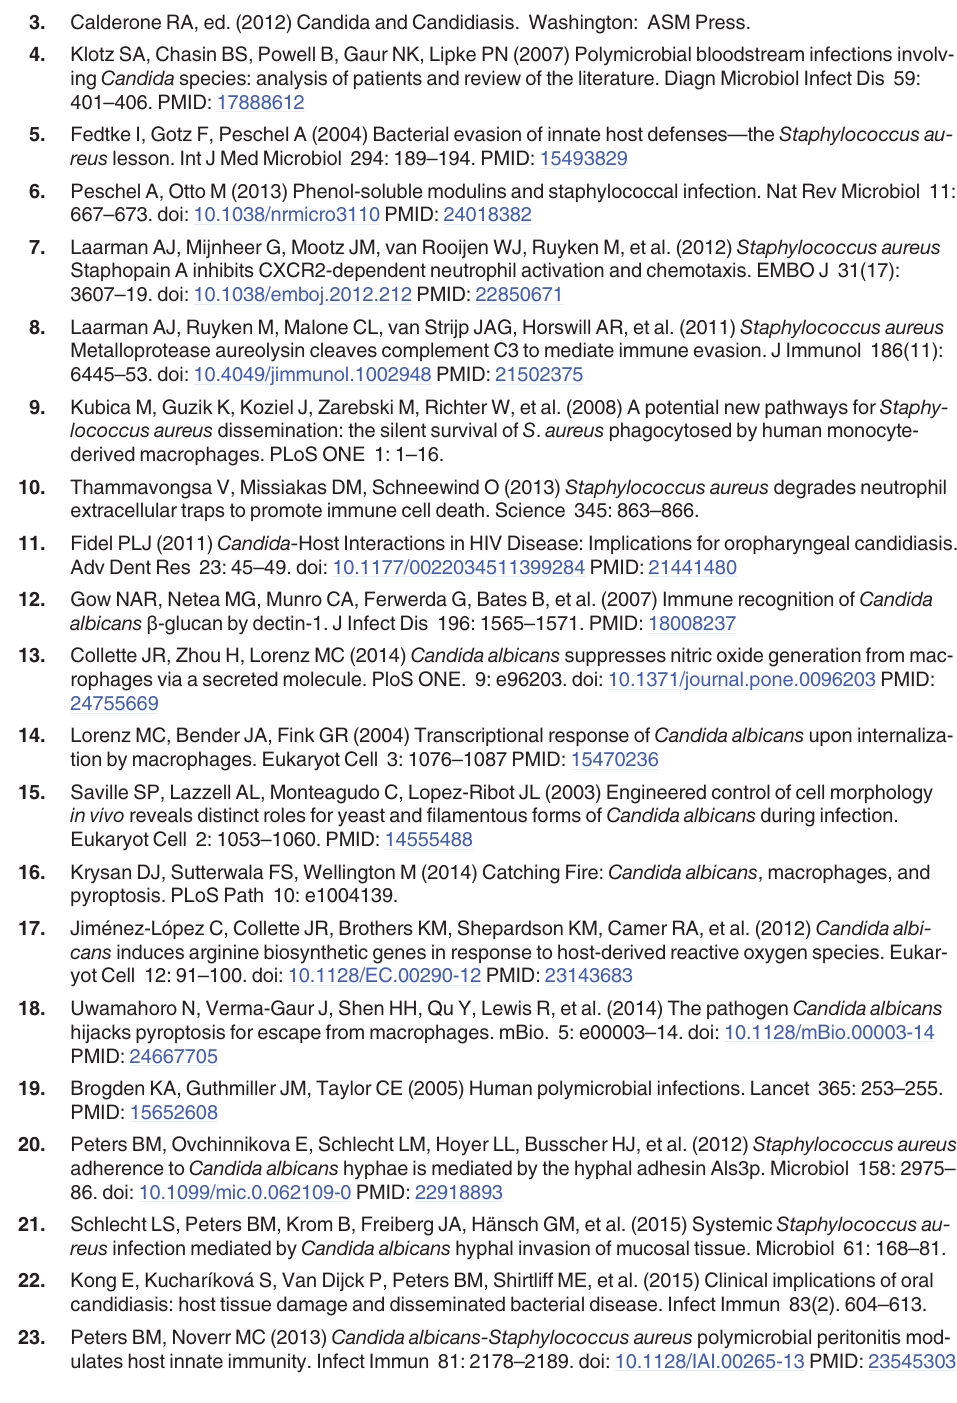
PLOS Pathogens | DOI:10.1371/journal.ppat.1004661 March 12,